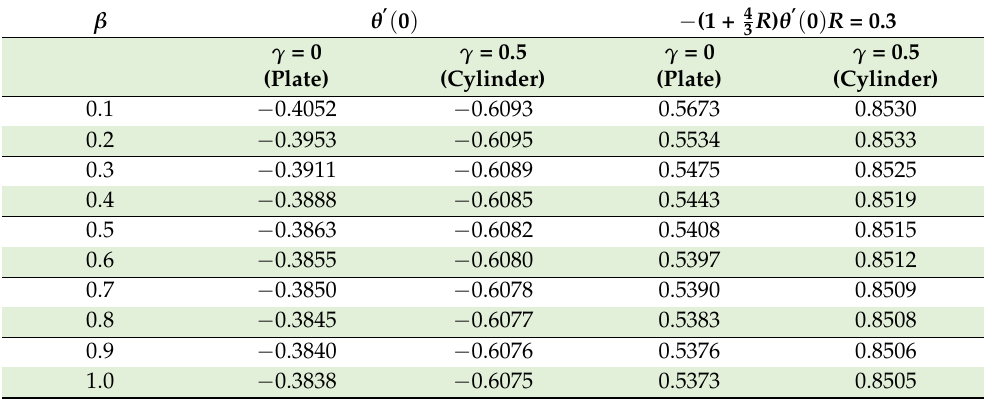
Table 7. Impact of β Nusselt number.